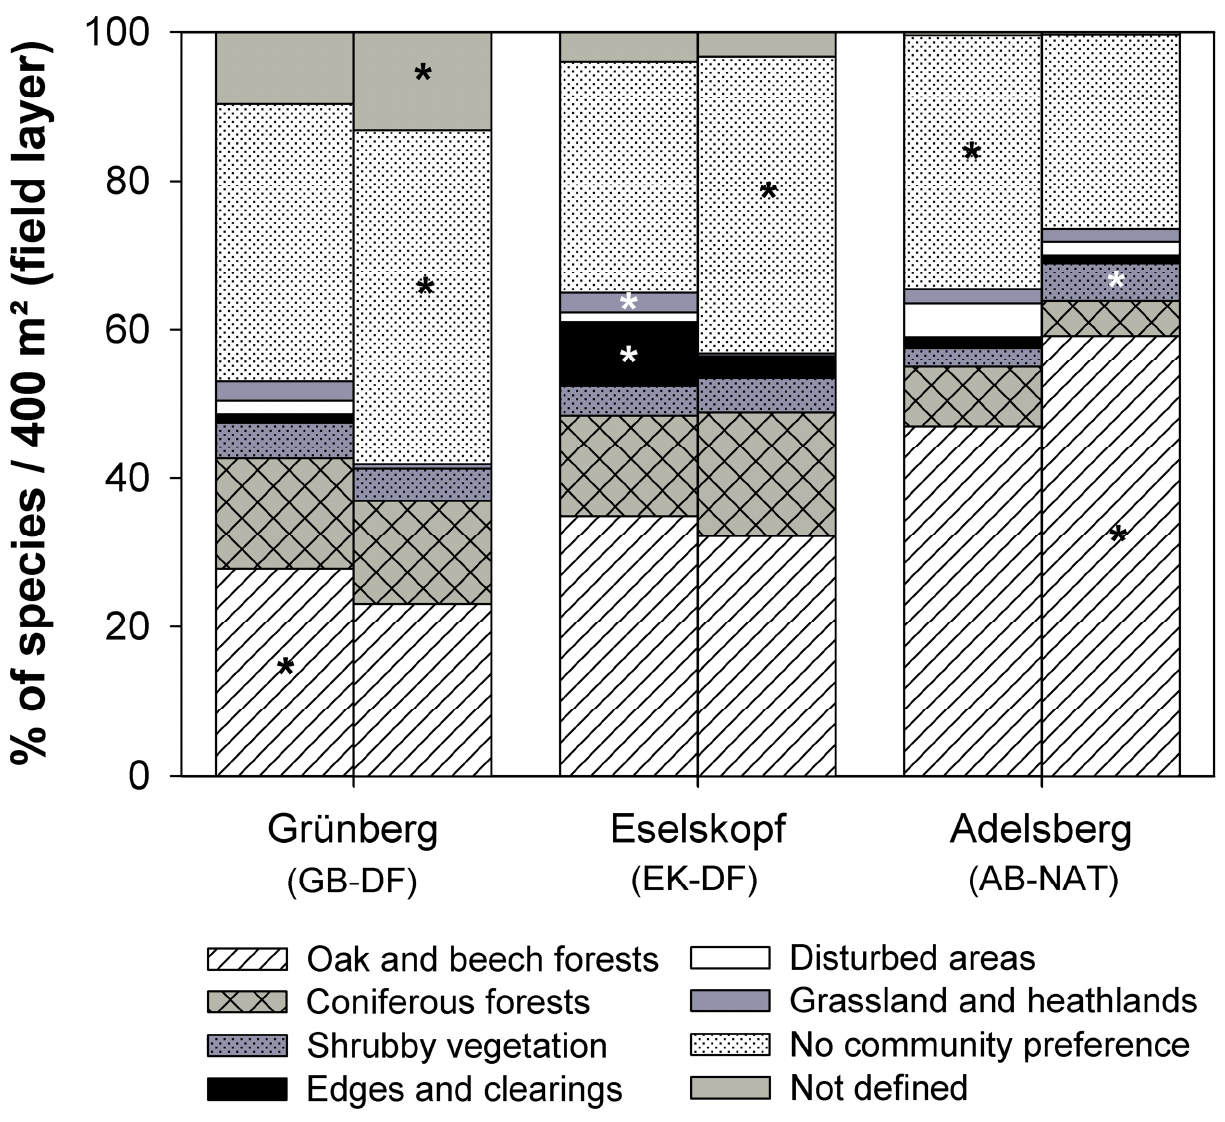
Figure 2. Percentage share of species of the field layer grouped according to their forest community preference. Left column = old survey, right column = recent survey. * marks significant differences between surveys ( p < 0.05). See text for